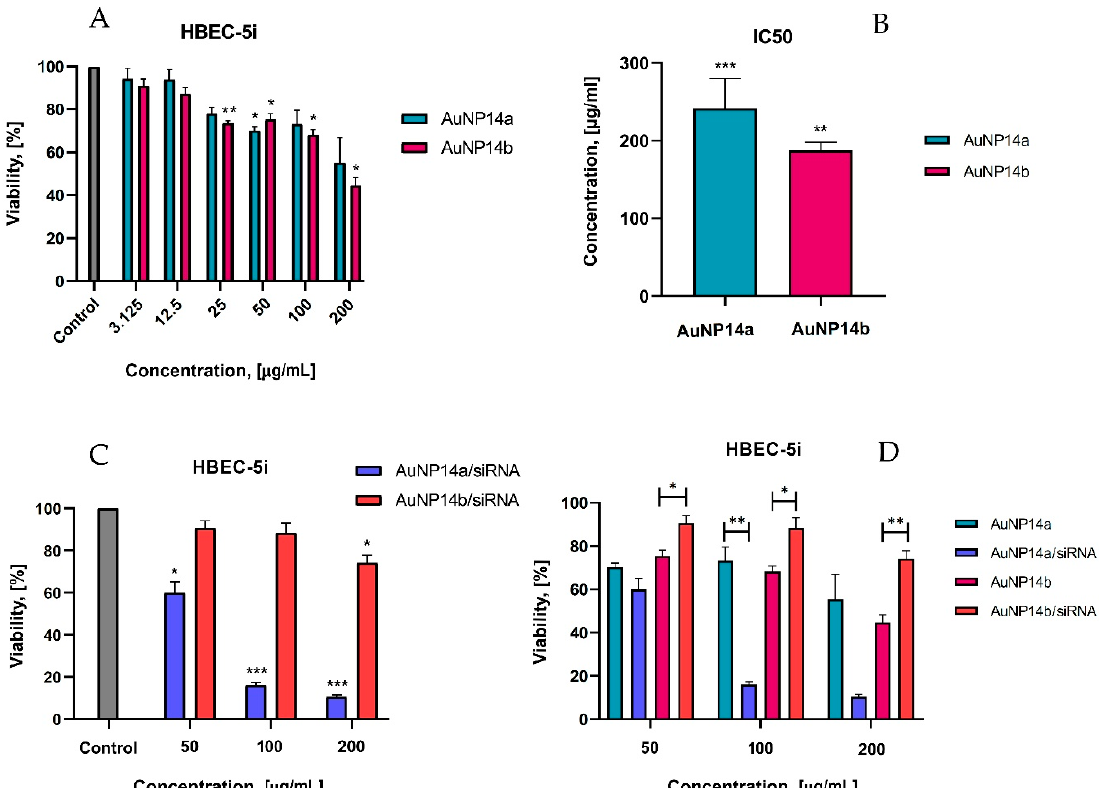
Figure 5. Cytotoxicity effect of AuNPs alone and their complexes with siRNA toward HBEC-5i cells, MTT assay. ( A ) The viability of HBEC-5i cells in the presence of AuNPs at the concentrations varied from 1.56 to 200 µ g/mL. Statistical significance showed when compared with the control, non-treated cells. ( B ) Calculated from the results shown on panel A, IC 50 , values of noncomplexed nanoparticles vs. control (100% viability). ( C ) The viability of HBEC-5i cells in the presence of AuNPs/siRNA complexes. Significant differences compared to the negative control. ( D ) Comparison of the cytotoxic e ff ects of naked AuNPs and their complexes with siRNA. Statistical signi fi cance was marked for the same concentrations between AuNPs alone and in the complex with siRNA. To form the AuNP/siRNA complex, the concentration of siRNA was always 1 µmol/L, whereas the concentration of nanoparticles was varied—incubation time for all samples 24 h. Data points represent means ± SD obtained from min. 3 separate experiments. Statistical signif